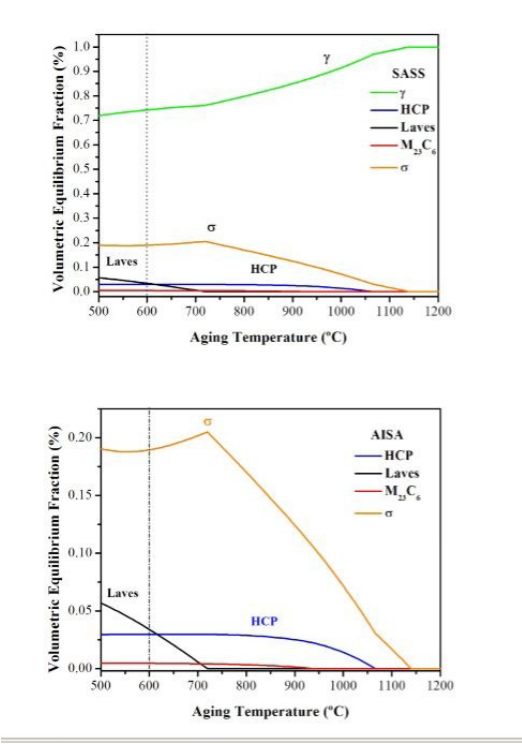
Figure 2. AL-6XN PLUS equilibrium precipitated phases obtained with Thermocalc® for the temperature range from 500 to 1200